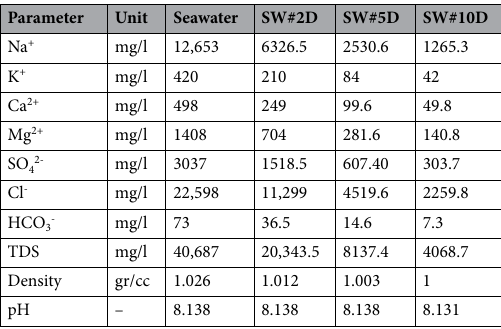
Table 2. Composition of diluted waters with different compositions of the Persian Gulf as IW.